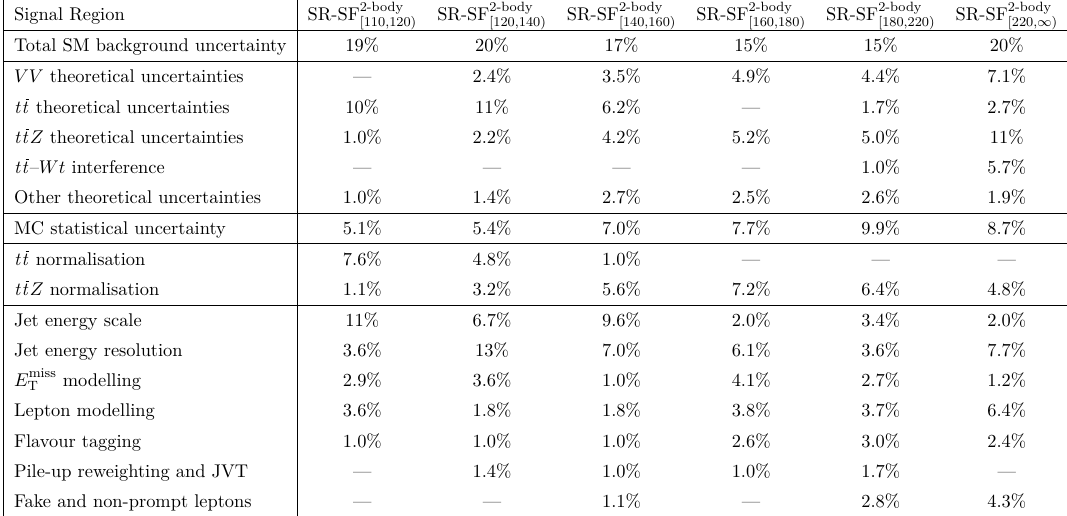
Table 12 . Two-body selection. Sources of systematic uncertainty in the SM background estimates, after the background fits, for the SF selection. The values are given as relative uncertainties in the total expected background event yields in the SRs. Entries marked ‘–’ indicate a contribution smaller than 1%. ‘MC statistical uncertainty’ refers to the statistical uncertainty from the simulated event samples. ‘Other theoretical uncertainties’ represent the theoretical uncertainty coming from V V V , tt t , tttt , tt W , tt WW , tt WZ , tt H , and tZ contributions. The individual components can be correlated and therefore do not necessarily add up in quadrature to the total systematic uncertainty.